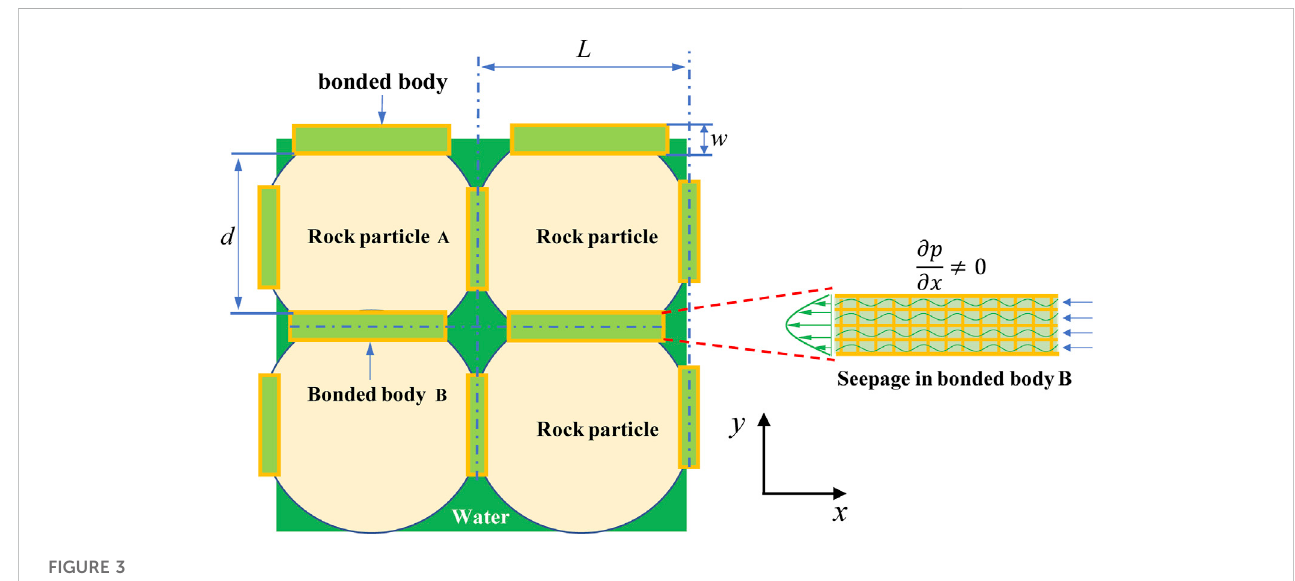
FIGURE 3 Size of the basic particle